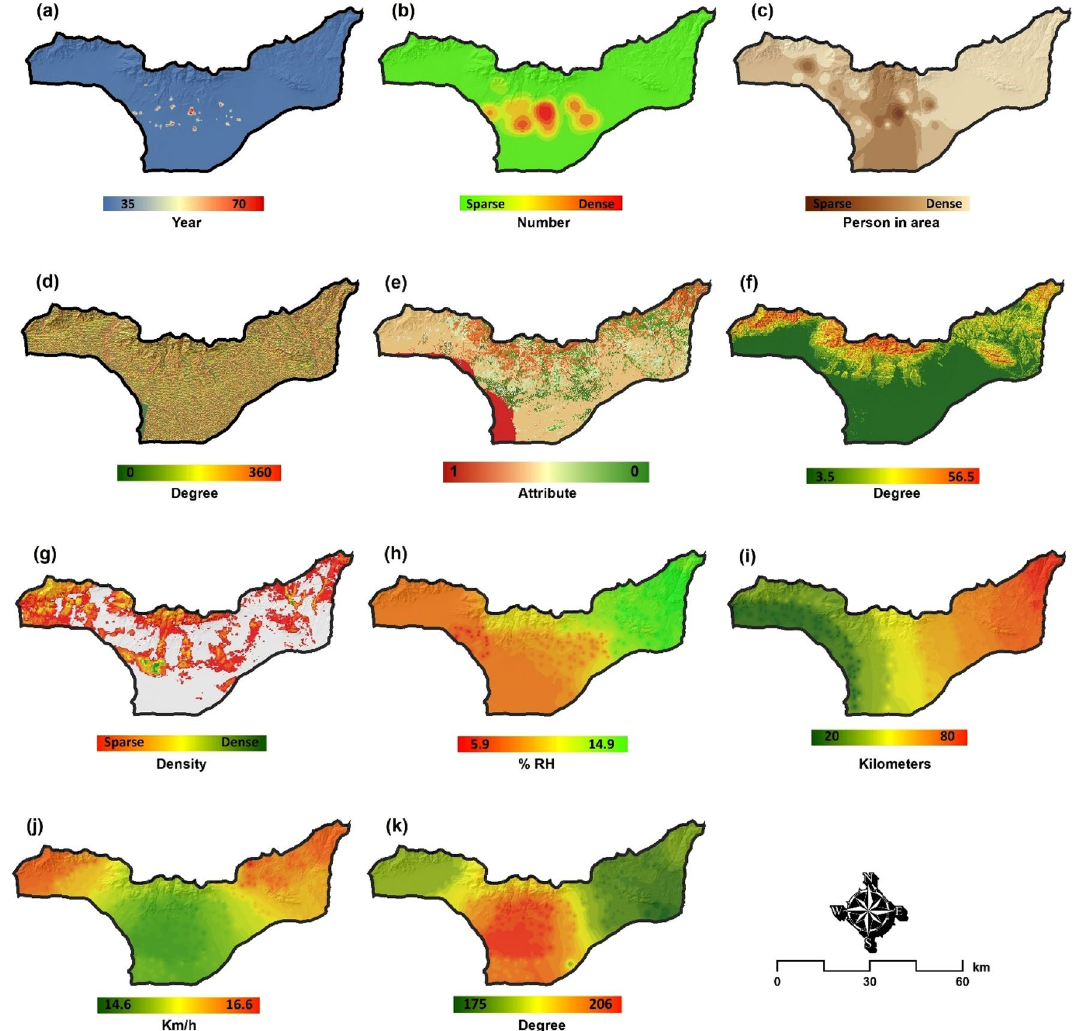
Figure 4. Spatial distribution of the selected criteria for the vulnerability and health risk mapping criteria: ( a ) population age group, ( b ) current status of hypertension, ( c ) population density, ( d ) slope-aspect, ( e ) land use/ cover, ( f ) slope, ( g ) vegetation continuous fields, ( h ) moisture, ( i ) distance to salt-center, ( j ) wind speed and ( k ) wind direction. Note : these data are taken from the initial source (e.g., topography, climatology, demography, or health dataset used in this research). The map is created in ESRI- Arc GIS version 10.7 under licenses of Humboldt-Universität zu Berlin (https:// deskt op. arcgis.